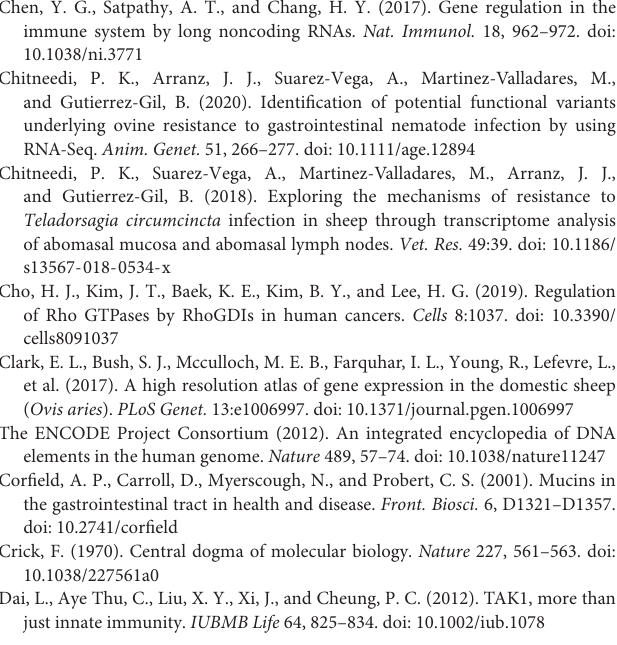
node transcriptome from resistant or susceptible sheep to GIN infection and to predict their potential functional role by gene co-expression and pathway enrichment analysis.